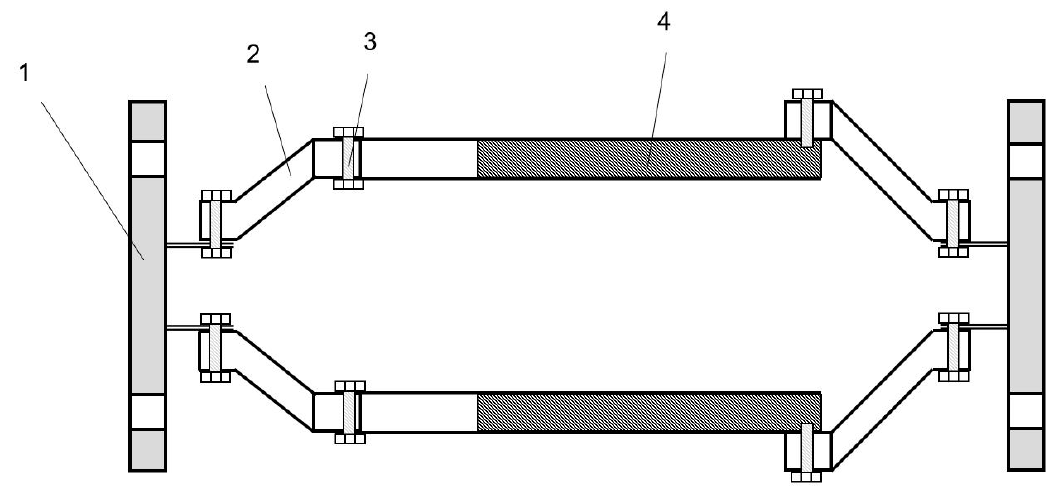
Figure 11. Structure of Faraday cylinder. (1) Flange (2) PVDF reducer (3) Fastener (4) Insulating rubber.